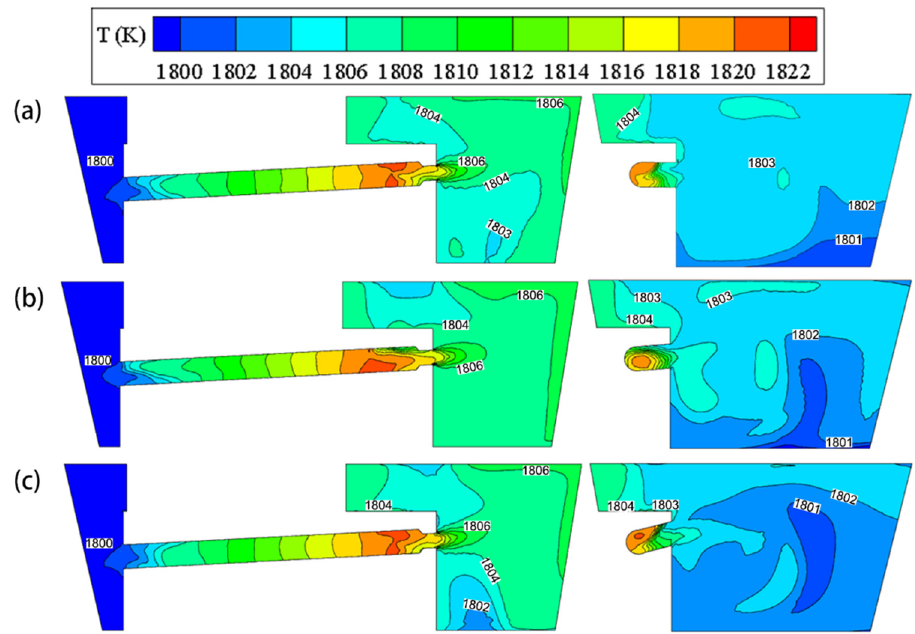
Figure 20. Temperature field in the longitudinal planes of main channel (left) and port (right) for split schemes: ( a ) FK-A0; ( b ) FK-A5; ( c )